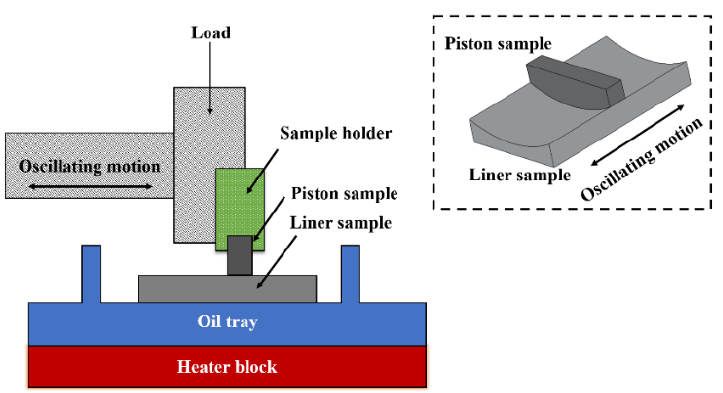
Figure 1. Schematic of the setup and the contact conditions between material pairs in a wear test of piston and cylinder liner (Adapted from Refs. [12,13]).